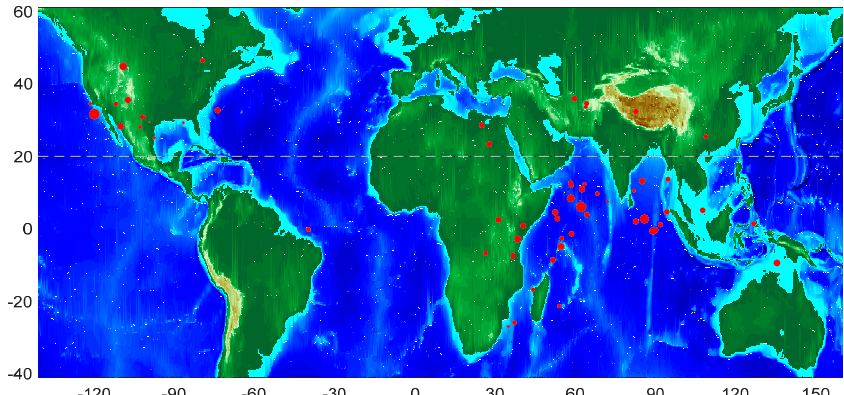
Figure 8. Locations of 61 mesospheric bores. Map colors indicate the terrain height, with the blue representing the oceans. The solid red dots indicate the locations where the mesospheric bore events were detected by the DNB, and the size of the dots denotes the widths of the bores.